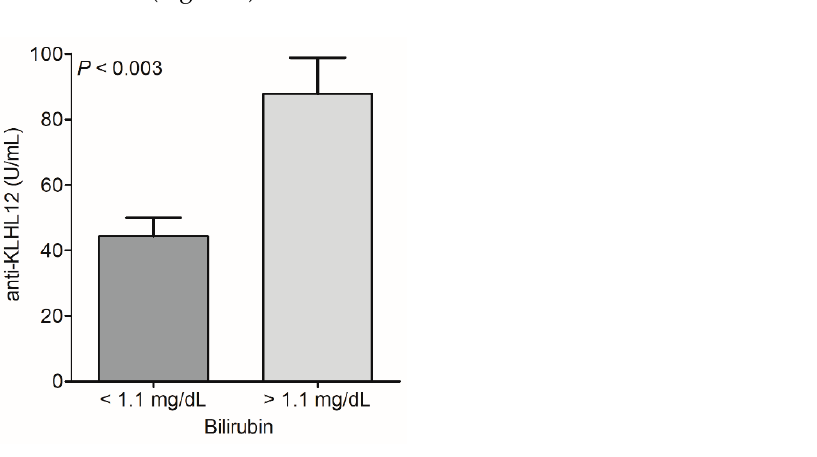
Figure 7. Level of anti-KLHL12 antibodies and bilirubin concentration in serum of PBC patients.